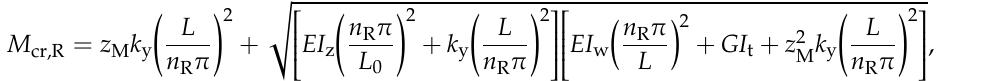
Figure 4. Given the shear sti ff ness contribution k y of the linear restraint (with k θ = 0), it was, thus,